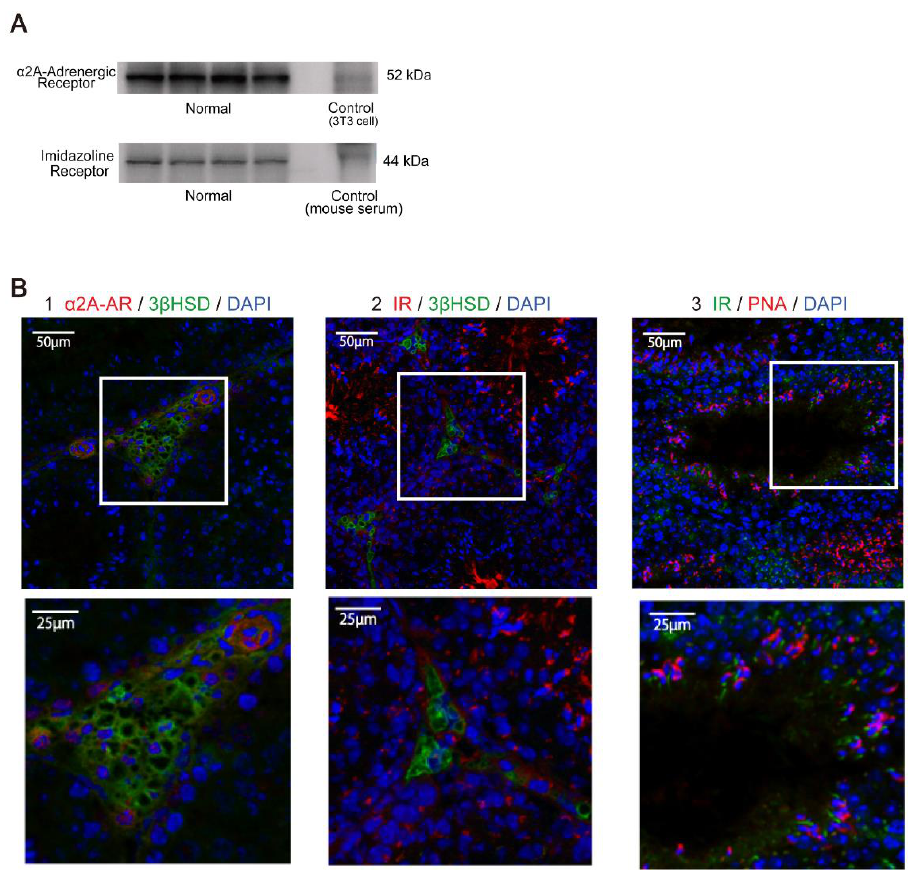
Figure 1. Localization and expression of α2A -adrenergic and imidazoline receptors in normal mouse. ( A ) α2A -adrenergic and imidazoline receptors were measured by Western blot in the testis of the normal group. ( B ) Localization sites of α2A - adrenergic receptor (α2A -AR) and imidazoline receptor (IR) were observed in the testis of the normal group by immunofluorescence analysis. (1) α2A - adrenergic receptors were stained with Alexa594, while 3βHSD (3 beta -hydroxysteroid dehy- drogenase) was stained with Alexa488. α2A -adrenergic receptors were expressed around the nu- cleus of Leydig cells and in vascular endothelial cells. α2A - adrenergic receptor, 3βHSD, and DAPI are shown in red, green, and blue, respectively. ( 2) IRs were stained with Alexa594, while 3βHSD was stained with Alexa488. IRs were expressed around the nucleus of Leydig cells. IR, 3βHSD, and DAPI are shown in red, green, and blue, respectively. (3) IRs were stained with Alexa488, while PNA was stained with Alexa594. Imidazoline receptors were expressed in sperm cells and the like in fine tubes. Imidazoline receptors, PNA, and DAPI are shown in green, red, and blue, respectively. 3.2. Effects of DEX Administration on Testicular Morphology and Receptors DEX treatment started from day 0 at 7:00 am to day 14. The sampling points from mice were 9:00 on day 14 (D14-9), 13:00 on day 14 (D14-13), 9:00 on day 15 (D15-9), and 13:00 on day 15 (D15-13). The testis weight/body weight ratio in the 10 µg/kg and 40 µg/kg groups was not significantly different compared to that in the normal and sham group at all sampling points (Figure 2A). Moreover, the testes in all groups showed no histological changes (Figure 2B). The α2A -adrenergic receptor and imidazoline receptor mRNA ex- pression levels were not significantly different from those of the normal group at all sam- pling points (Figure 2C). Therefore, the receptors on which DEX acts and testicular histol- ogy were not affected by DEX administration. Albeit statistically significant, the differ- ences in the imidazoline receptor mRNA expression levels in the following comparisons were rejected because they did not meet our criteria for significance: 10 µg/kg compared to sham on D14-9 ( p = 0.018); 10 µg/kg compared to sham ( p = 0.002) and 40 µg/kg